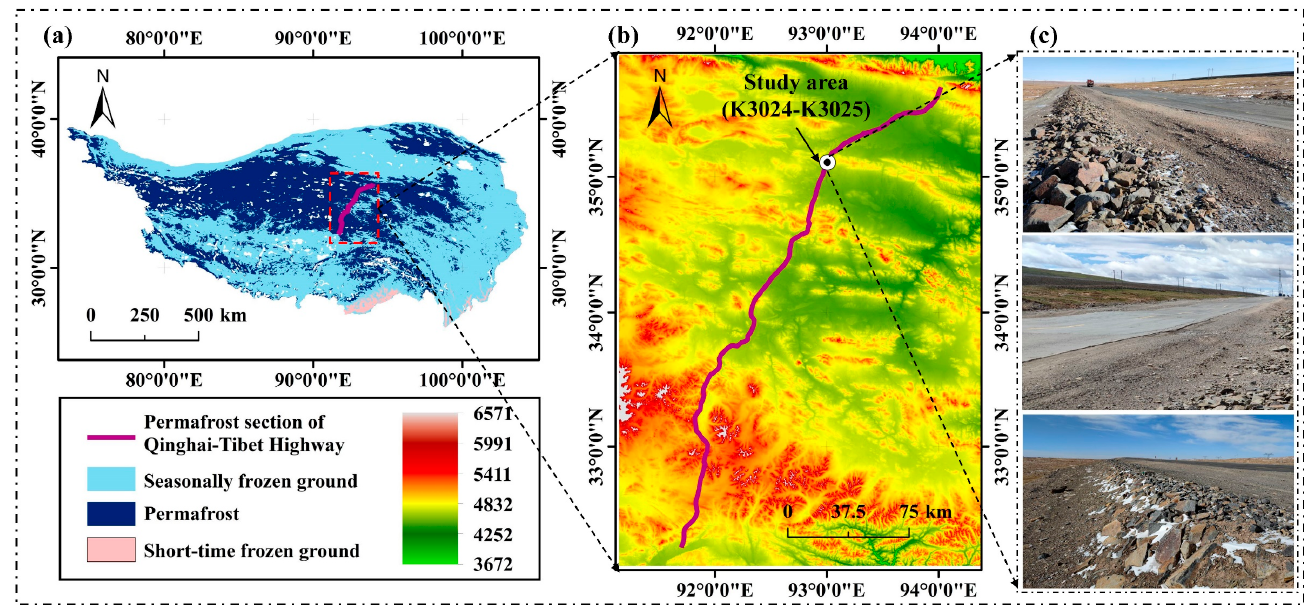
Figure 2. Study area: ( a ) spatial distribution of permafrost region in the QTP (the permafrost map is from [61,62]); ( b ) the location of k3024 to K3025 in the QTH; ( c ) field photographs of k3024 to k3025, from top to bottom: “wavy” pavement; local settlement of embankment and the block-stone em- bankment.